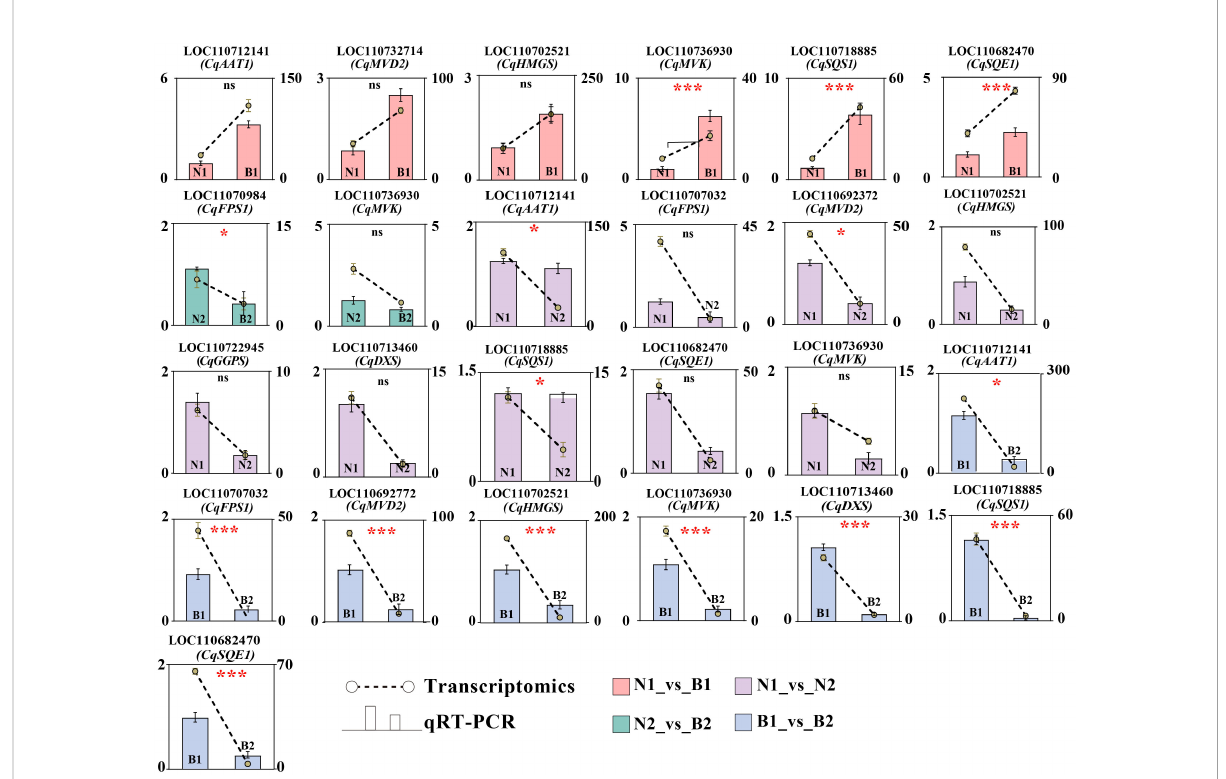
FIGURE 5 Veri fi cation of candidate differentially expressed genes (DEGs) by qRT-PCR. The Y-axis as the ordinate denotes the Fragments Per Kilobase of exon model per Million mapped fragments (FPKM) values. The ncbi serial number and name of the DEGs in N1_ vs _B1, N2_ vs _B2, N1_ vs _N2, and B1_ vs _B2 were marked in pink, green, purple, and blue, respectively. The error bars for qRT-PCR and transcriptomics were marked in black and yellow, respectively. In this fi gure, “ ns, ” “ *, ” and “ *** ” mean p > 0.05, p < 0.05, and p < 0.001,